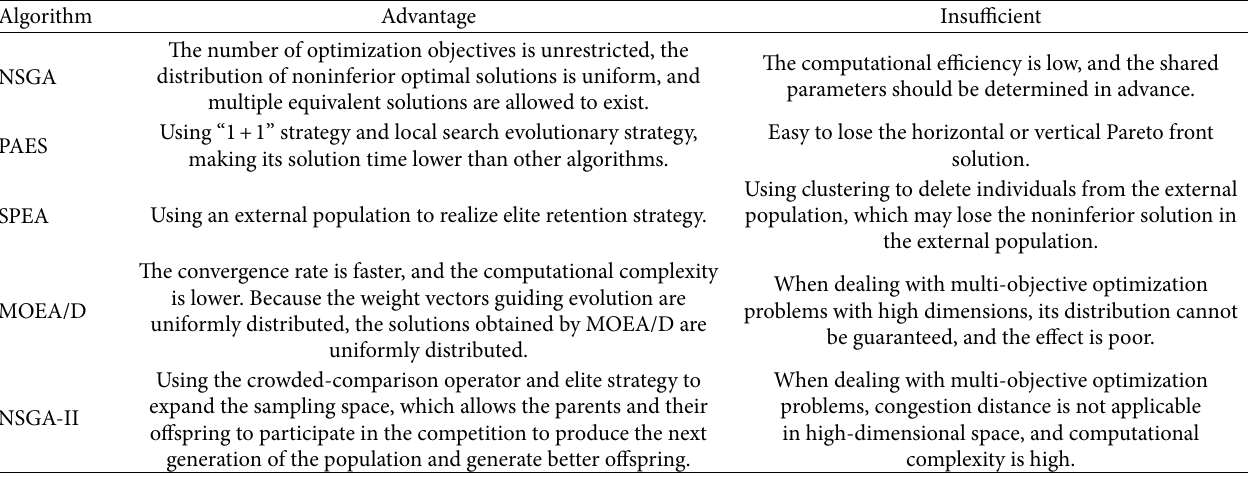
Table 6: Comparative analysis of several major multi-objective optimization